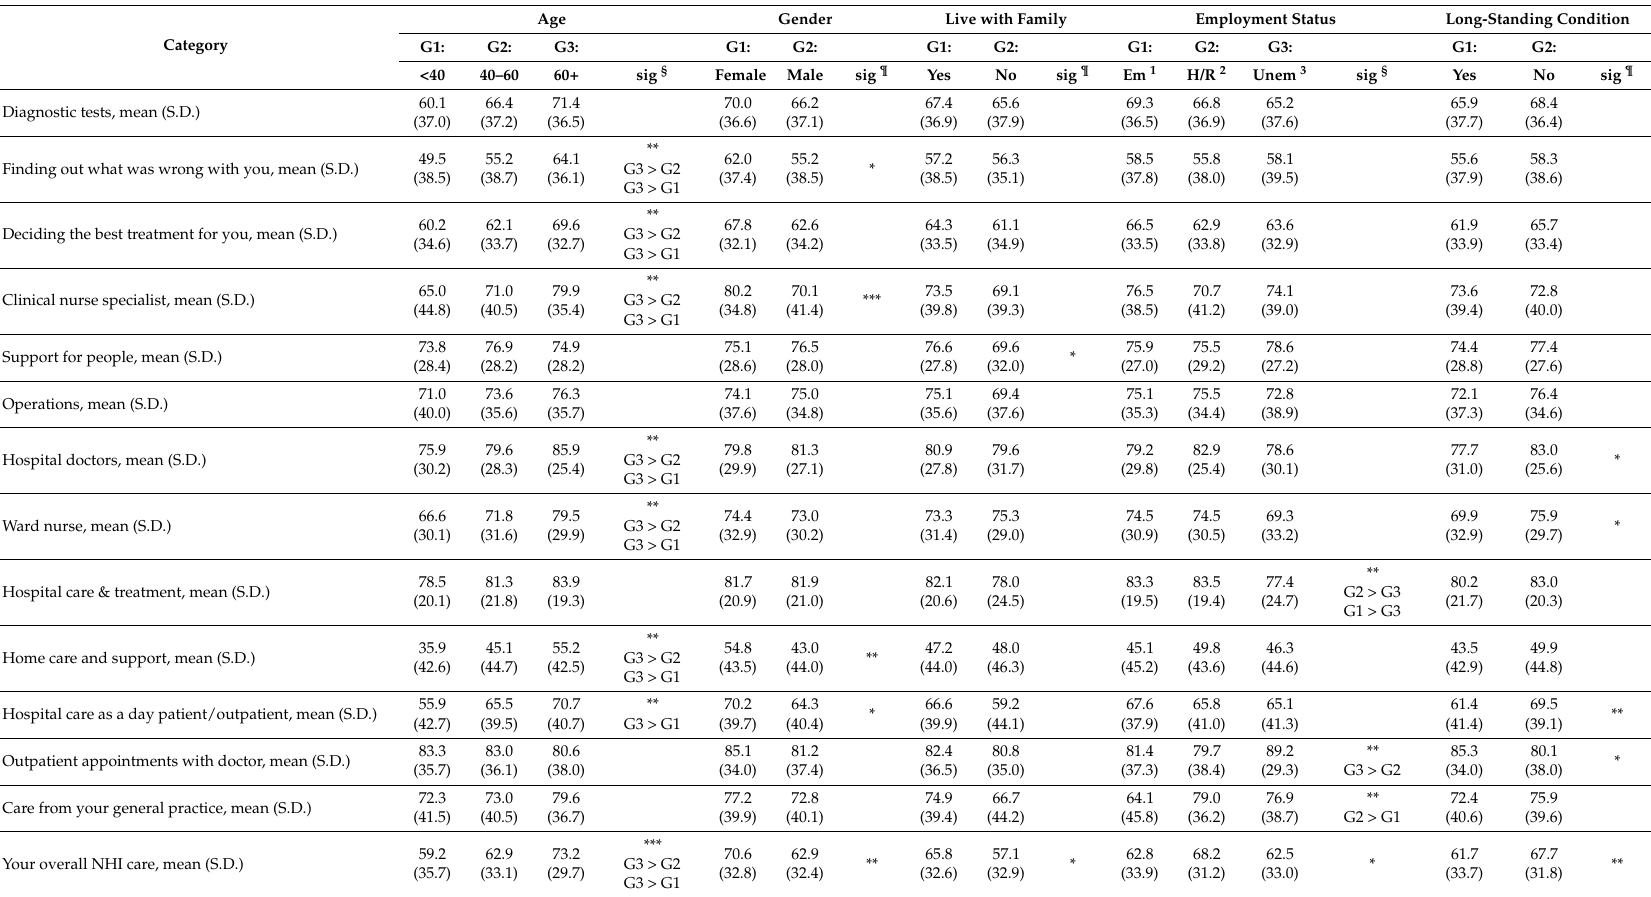
Table 4. Experience of cancer care: categories vs. cancer-specific